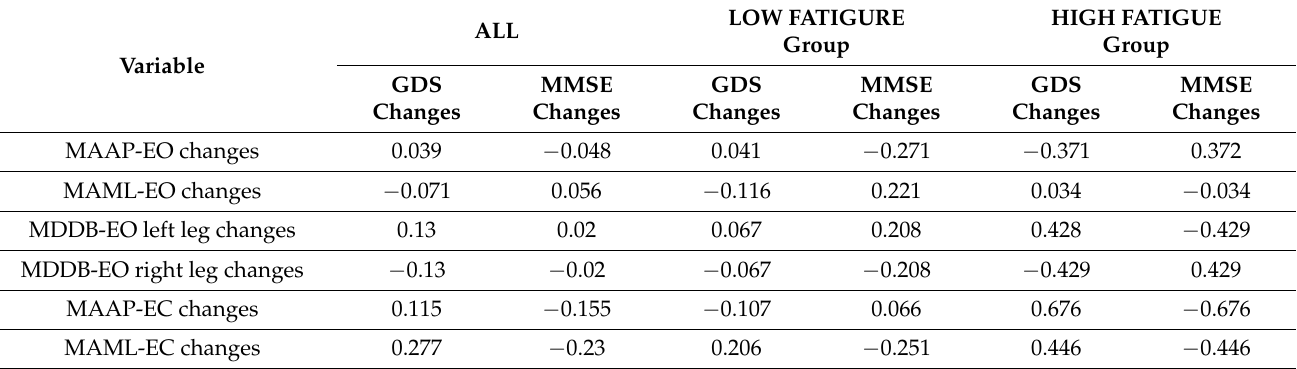
Table 5. Correlations between results of stabilometric platform, GDS, and MMSE test results among MS patients over the age of 65 with low and high